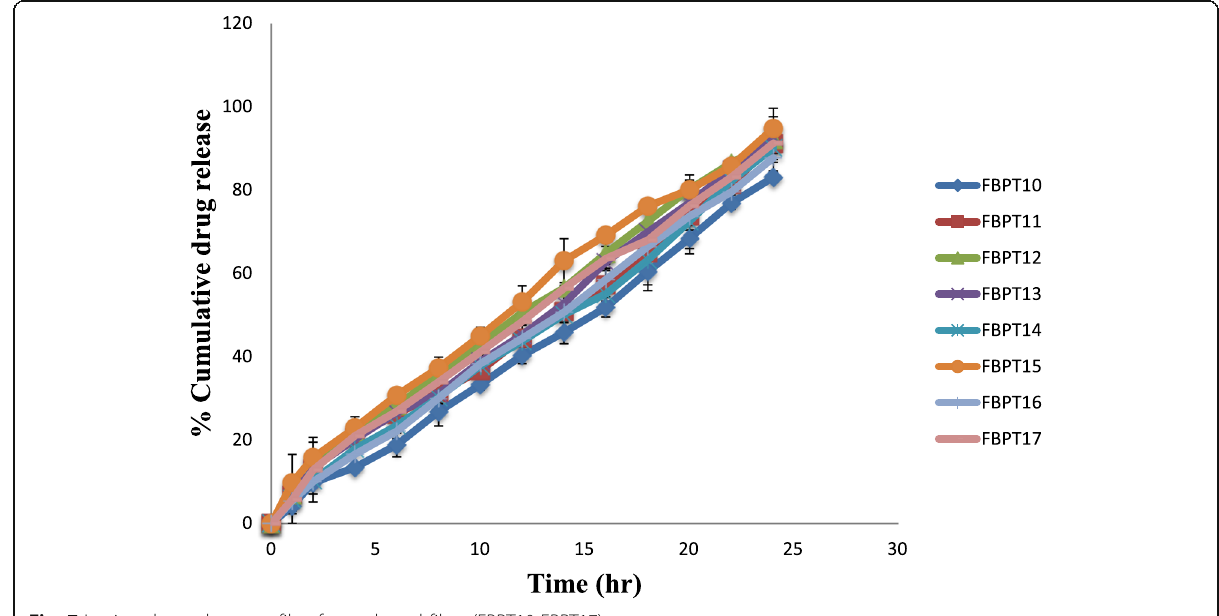
Fig. 7 In vitro drug release profile of transdermal films (FBPT10-FBPT17)